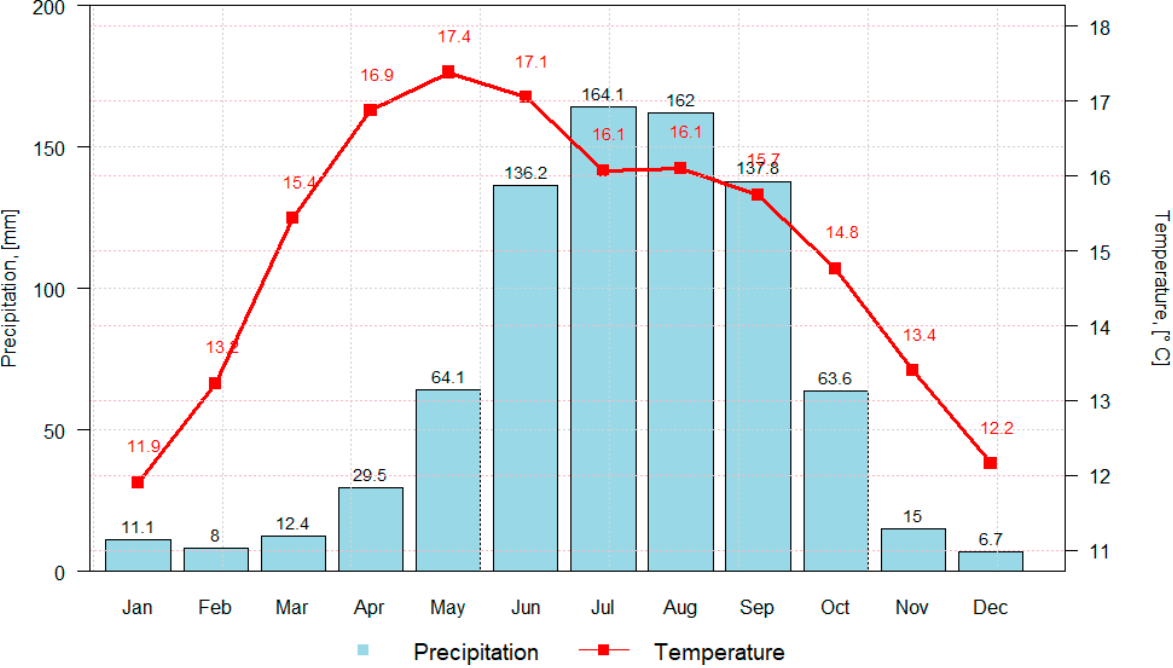
Figure 4. Climograph with the arithmetic average for precipitation (bars, in mm) and mean temperature (red line, in °C) of the 90 stations in the study region.